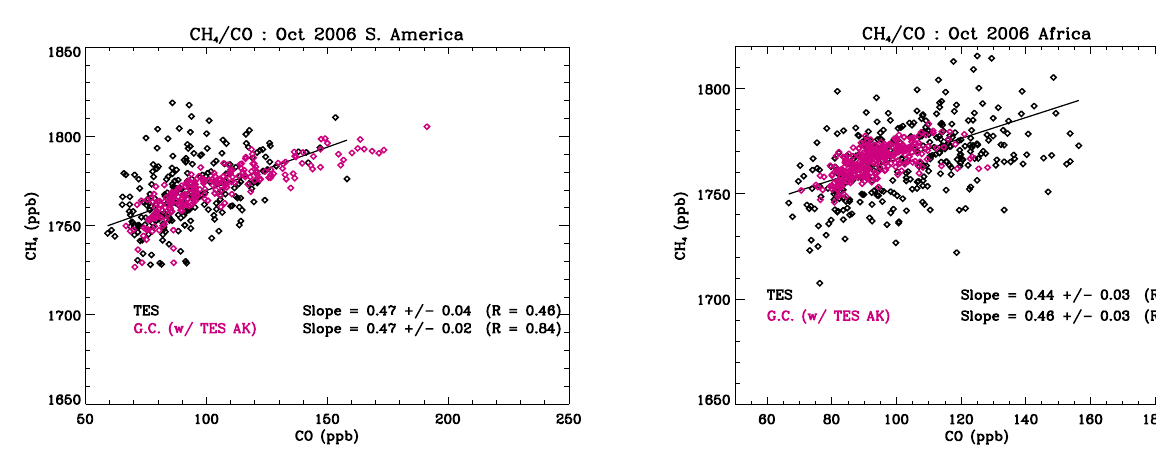
Fig. 11. Distribution of CH 4 and CO over African fires. The TES data are shown in black. The GEOS-Chem data (adjusted with the TES operator) are in red. A linear fit to the TES data is shown as a black